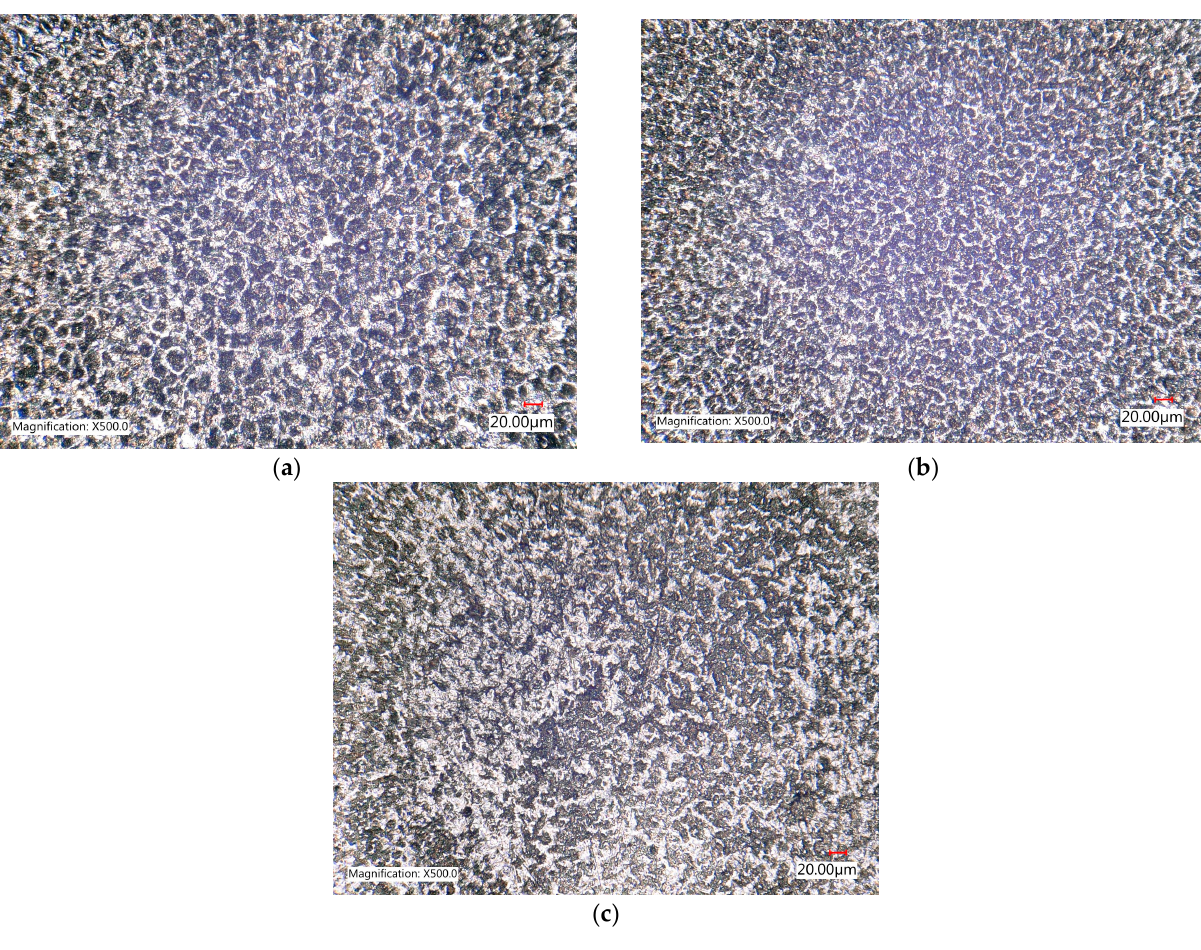
Figure 2. Typical surface microstructure of AISI 304 SS specimens oxy-nitrided by SSONPE in aqueous solutions of 0.3% NH 4 NO 3 and urea at concentrations of: ( a ) 20 wt%, ( b ) 30 wt% and ( c ) 40 wt%.